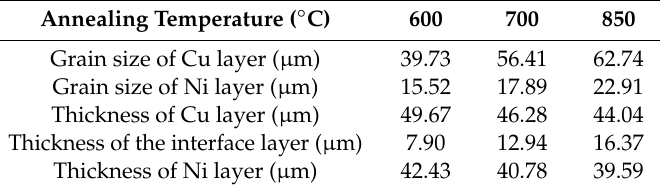
Figure 2. Micro-structures of billets along a rolling direction at different annealing temperatures ( a ) 600 °C, ( b ) 700 °C, and ( c ) 850 °C. Table 1. Grain size and thickness of the component layer.